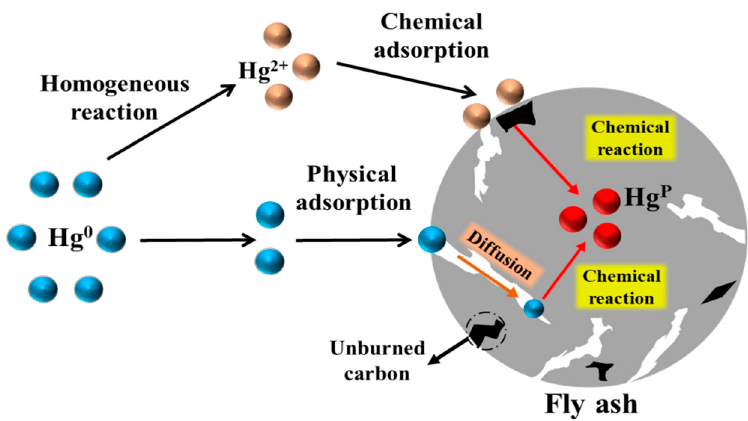
Figure 7. Schematic diagram of gaseous Hg migration from the flue gas to the fly ash.